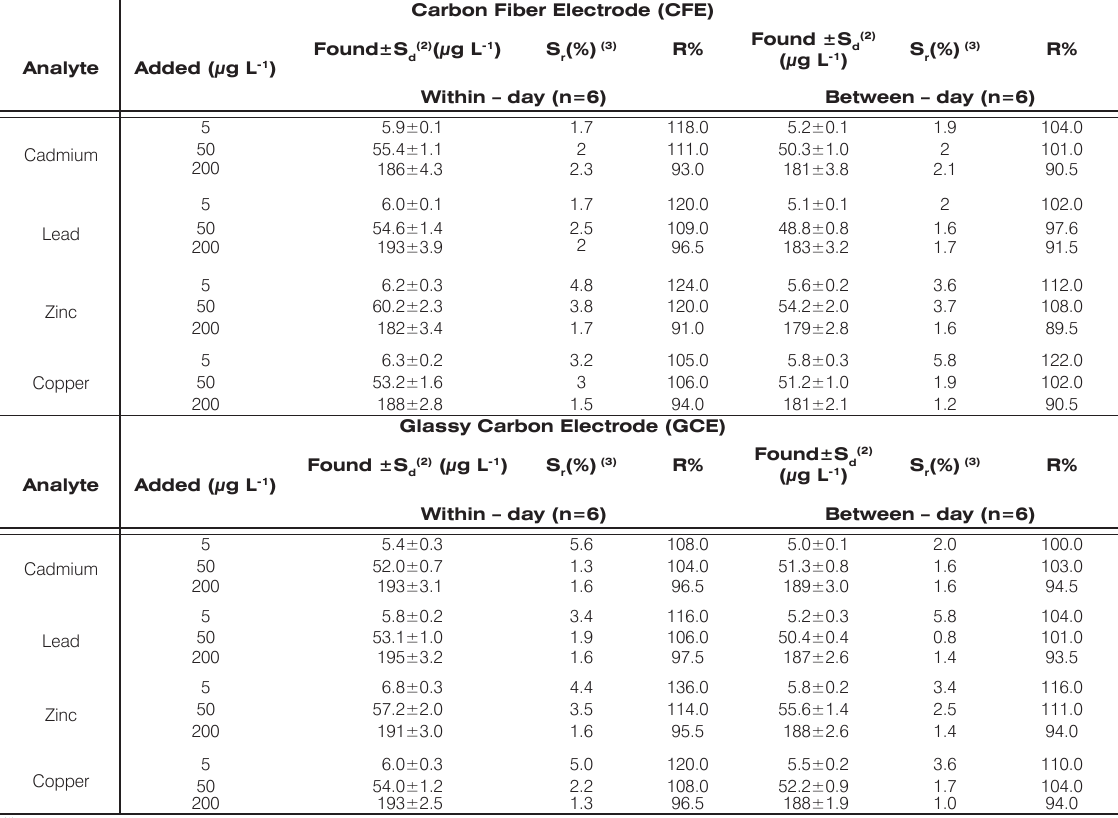
Carbon Fiber Electrode